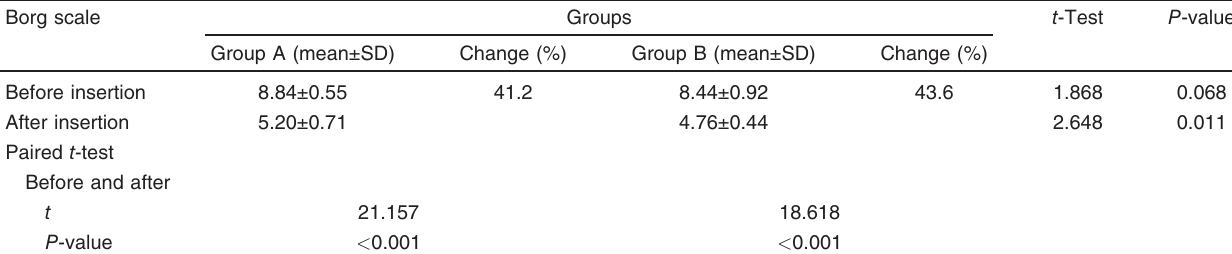
Table 2 Comparison of the modified Borg dyspnea scale in groups A and B before and insertion of a tube and a catheter Borg scale